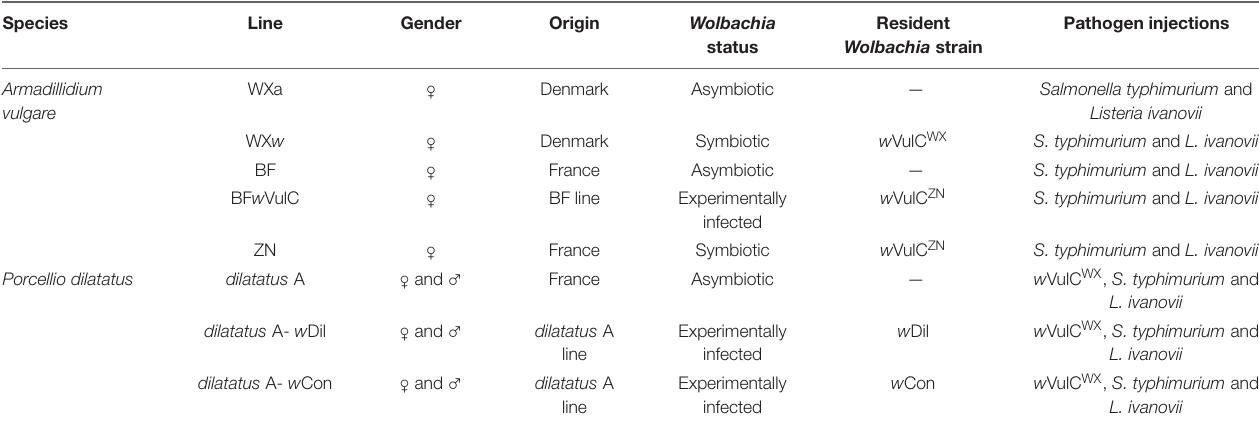
TABLE 1 | Isopod lines used in this study and their main characteristics: gender of studied animals, their origins, their symbiotic condition [asymbiotic, symbiotic (naturally or experimentally infected)], the Wolbachia strain that they harbor. Species